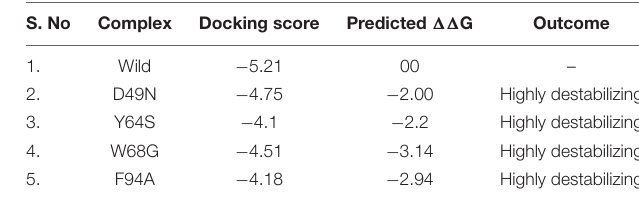
TABLE 1 | Molecular docking scores of the wild and mutant complexes. The mCSM predicted stability changes upon mutation. All the energies are given in